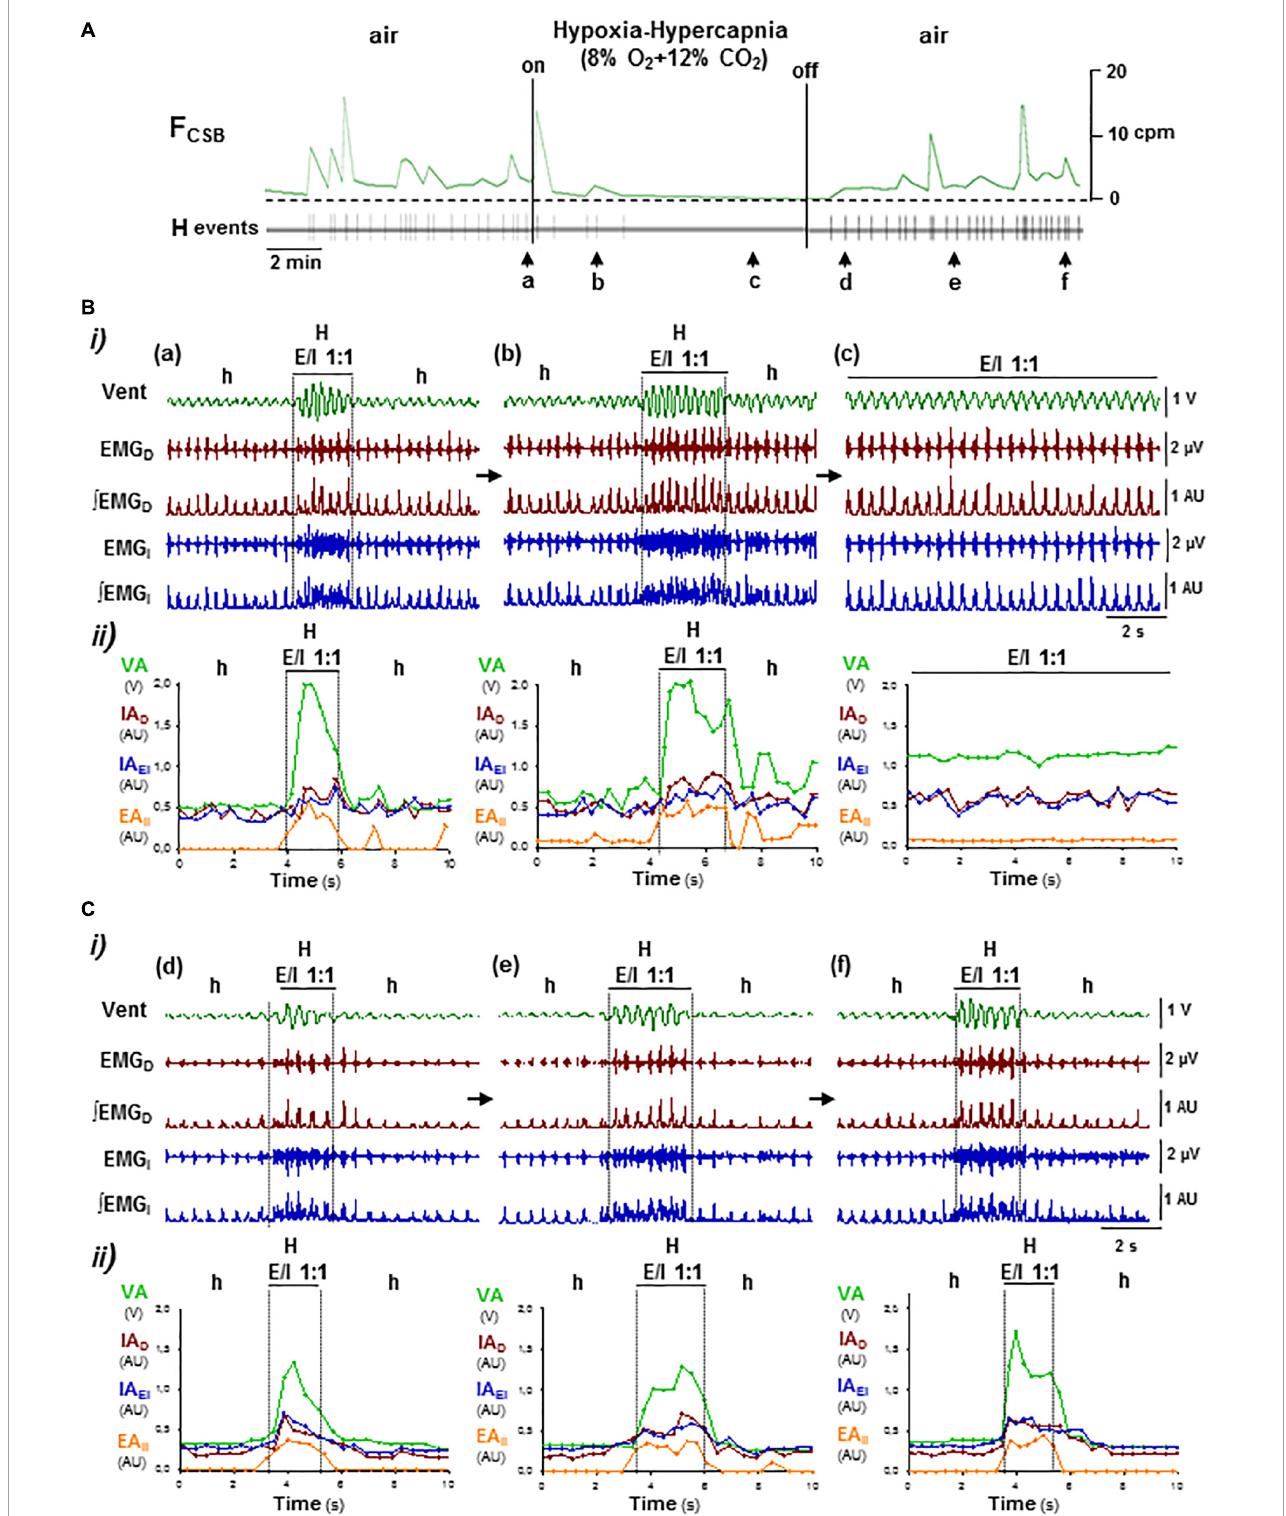
FIGURE8 OFF/ON reconfigurations of CSB motor pattern induced by hypoxia–hypercapnia. Symbols as in Figure 5 . (A) Administration and removal of low O 2 (8%) with high CO 2 (12%) in inhaled air suppressed and rebooted CSB, respectively. (B,C) Off and on reconfigurations of the respiratory motor pattern leading to suppression ( a–c in B ) and reboot of CSB ( d–f in C ). Hypoxia–hypercapnia stimulus enhanced and regularized breathing by turning expiratory/inspiratory coupling from cyclic to continuous ( E/I 1:1 , a–c ). The reintroduction of medical air abolished expiratory activity and caused a profound depression of inspiratory activity and ventilation over which CSB rebooted gradually (d–f)